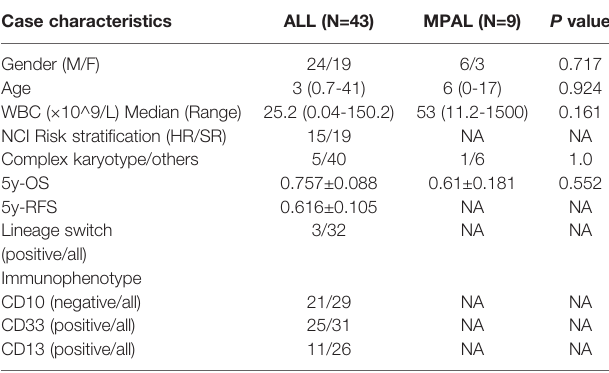
TABLE 1 | Clinical characteristics of TCF3-ZNF384 positive ALL and